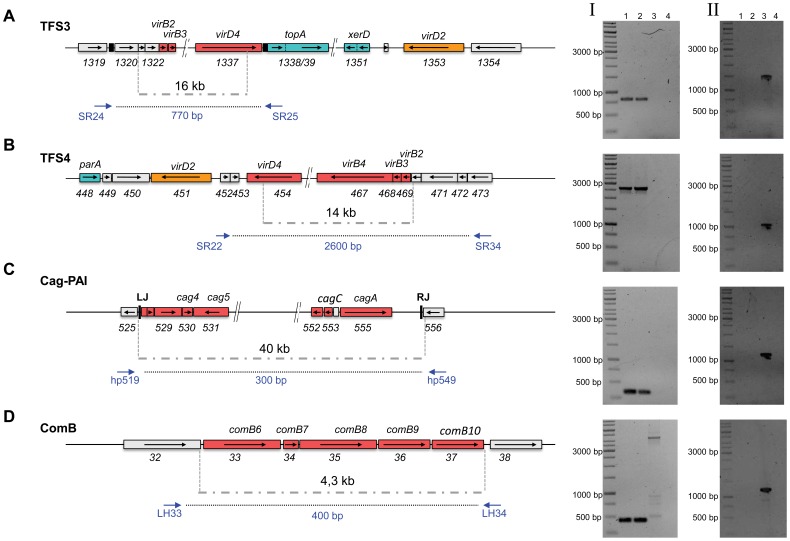
Deletion of individual T4SS from the genome of H. pylori strain P12 by the marker-free counterselection procedure.(A) Schematic representation of Tfs3 and verification of its deletion. For deletion of the complete Tfs3 (16 kb region), the flanking sequences were amplified using oligos SR17/SR18 and SR30/SR35 (see Table S1 for primers) and cloned into the pBluescript vector either with or without the rpsL-erm cassette in-between. Verification of the correct deletion was obtained by DNA amplification of a genomic fragment using oligos SR24/SR25 resulting in a PCR fragment of 0.77 kb, as expected (gel I). The PCR fragment was further verified by DNA sequencing. Furthermore, amplification of an internal region of Tfs3 (primers WS542/355) resulted in the expected PCR product from wt, but not P12ΔT4SS chromosomal DNA (gel II) (B) For deletion of the complete Tfs4 (14 kb region) the flanking sequences were amplified using oligos SR13/SR14 and SR32/SR34 (see Table S1 for primers) and cloned into the pBluescript vector either with or without the rpsL-erm cassette enclosed. Verification of the correct deletion was obtained by DNA amplification of a genomic fragment using oligos SR22/SR34, resulting in a 2.6 kb fragment, as expected (gel I). The PCR fragment was further verified by DNA sequencing. Amplification of an internal region of Tfs4 (primers SR48/49) resulted in the expected PCR product from wt, but not P12ΔT4SS chromosomal DNA (gel II) (C) The complete cag-PAI was deleted by the rpsL-counterselection procedure. Flanking fragments were cloned using oligos JP22/23 and JP24/25 for PCR (see Table S1 for primers). The correct deletion was verified by the generation of a PCR fragment of 300 bp spanning the deletion, as generated by primers hp519 and hp549. The PCR fragment was further verified by DNA sequencing. Amplification of an internal region of the cag-PAI (primers WS418/HP542f) resulted in the expected PCR product from wt, but not P12ΔT4SS chromosomal DNA (gel II). (D) Deletion of the comB6– comB10 genes of the comB T4SS by the rpsL-counterselection procedure (4.3 kb). Flanking regions were cloned using oligos AK59/AK65 and DHO10/DHO11 for PCR (see Table S1 for primers). The deletion was verified by the generation of a 400 bp fragment, whereas the intact comB locus resulted in a 4300 bp fragment. Amplification of an internal region of comB (primers DHO14/DHO15) resulted in the expected PCR product from wt, but not P12ΔT4SS chromosomal DNA (gel II). Components with sequence homology to the VirB/D4-System of A. tumefaciens are shown in red; other elements important for the potential function of the T4SS are depicted in blue or orange. Lane M, 1 kb ladder; lane 1 donor strain P12ΔT4SS; lane 2, recipient strain P12ΔT4SS; lane 3, P12 wt strain; lane 4: water control.